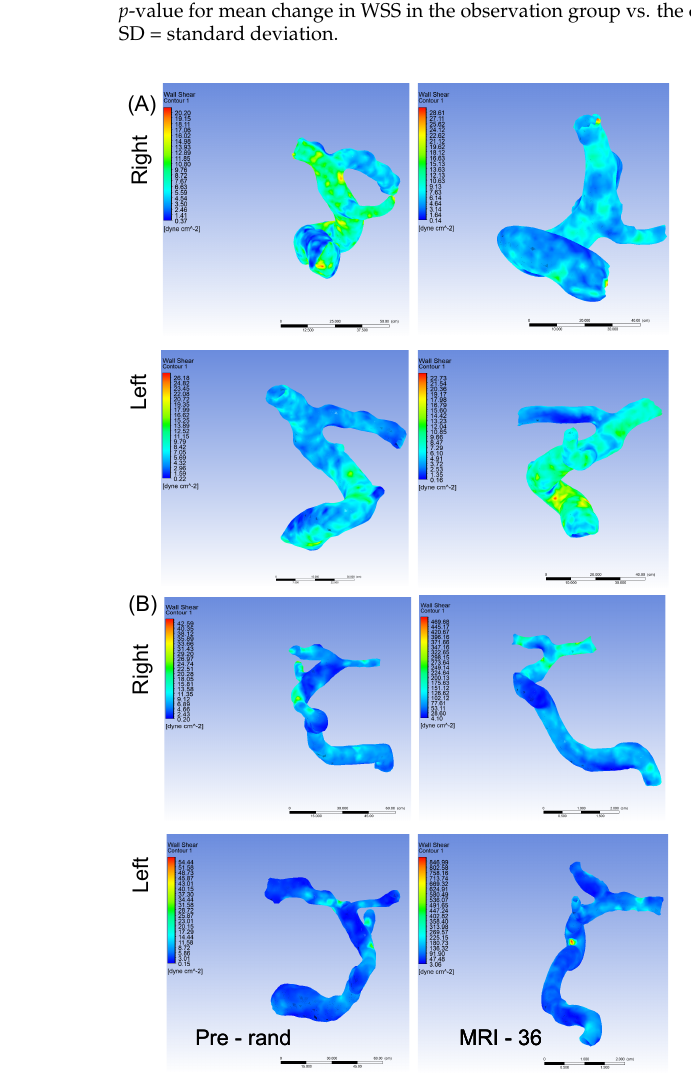
Figure 3. Panel “( A )” represents wall shear stress in a participant in the observation arm with MRA at Figure2. IntheBoultetal.[4]frameworkfornovelty,thecriticalelementsfordefiningnoveltyare task-dependentdissimilarityfunctions D w , ,andassociatedthresholds δ w and δ o forthe pre-randomization and after 36 months. In the right ICA WSS further decreased from 6.9 dynes/cm 2 T ; E t D o , T ; E t worldandobservationalspacerespectively. Thispapershowsthatmultipledissimilarityoperators supportdefiningmultiplesubtypesofnovelty(e.g., novelagents, novelactionsbyagents, novel pre-randomization to 5.0 dynes/cm 2 at 36 months, while in the left ICA the WSS increased from interrelations, etc). We also define a WOW-agent agent-dissimilarity-operator and show how to useExtremeValueTheory(EVP)todealwiththeinherentuncertaintyintheworldwhiledefining 5.0 dynes/cm 2 to 6.9 dynes/cm 2 . Panel “( B )” represents wall shear stress in a participant in the cRBC treatment arm with MRA at pre-randomization and after 36 months. In the right ICA WSS increased from 6.2 dynes/cm 2 pre-randomization to 85.5 dynes/cm 2 at 36 months, while in the left ICA the WSS increased from 5.3 to 88.3 dynes/cm 2 . cRBC = chronic red blood cell infusion, MRA = magnetic resonance angiography, WSS = wall shear